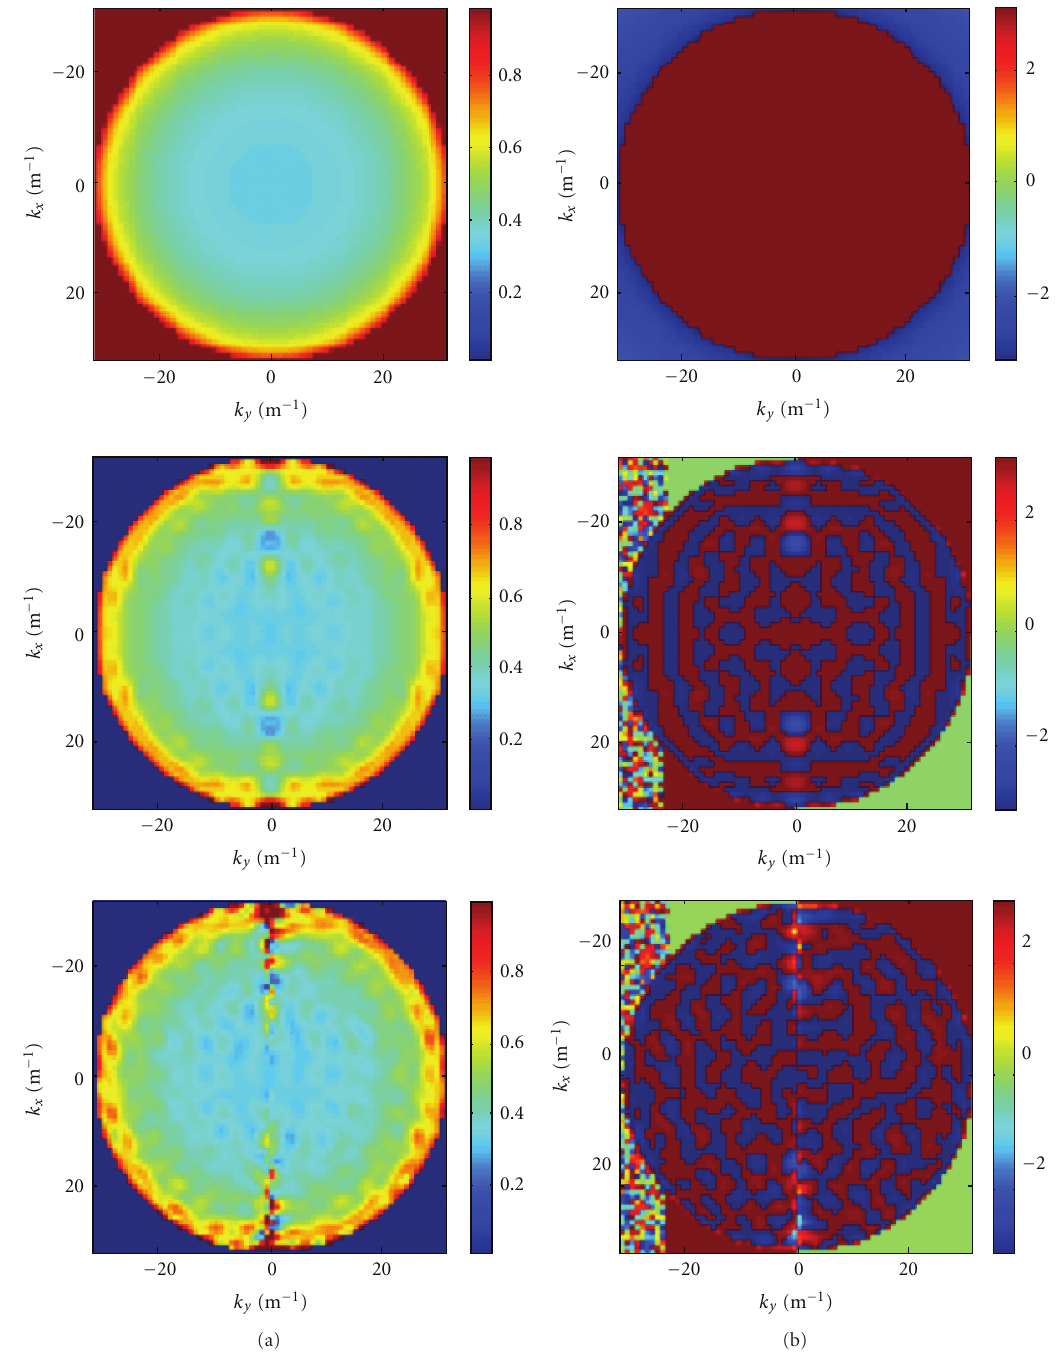
Figure 4: Soil 1. Amplitude (a) and phase (b) of Γ TE . Top line: actual values; middle line: noiseless estimation; bottom line: noisy